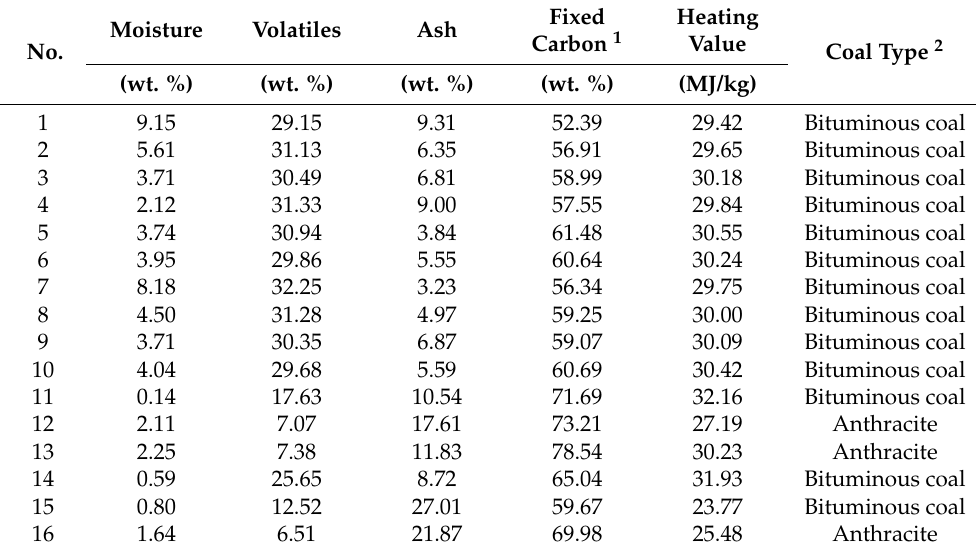
Table 1. Proximate analysis of 16 coal samples (air-dried